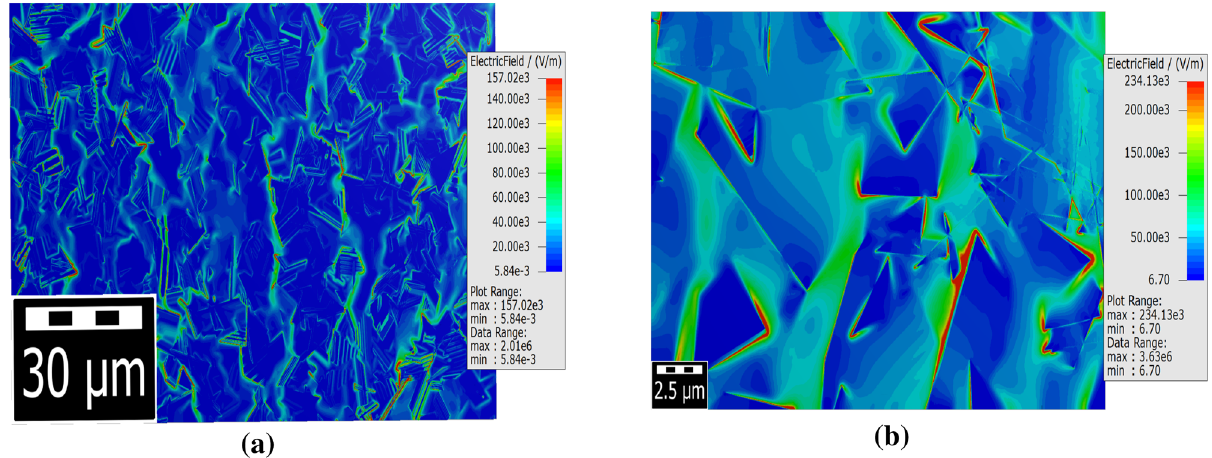
Fig. 5 Visualisation of the electrostatic field distribution for a full-scale a and a small detail b of a graphene ink layer